Question: Describe this figure in one sentence.
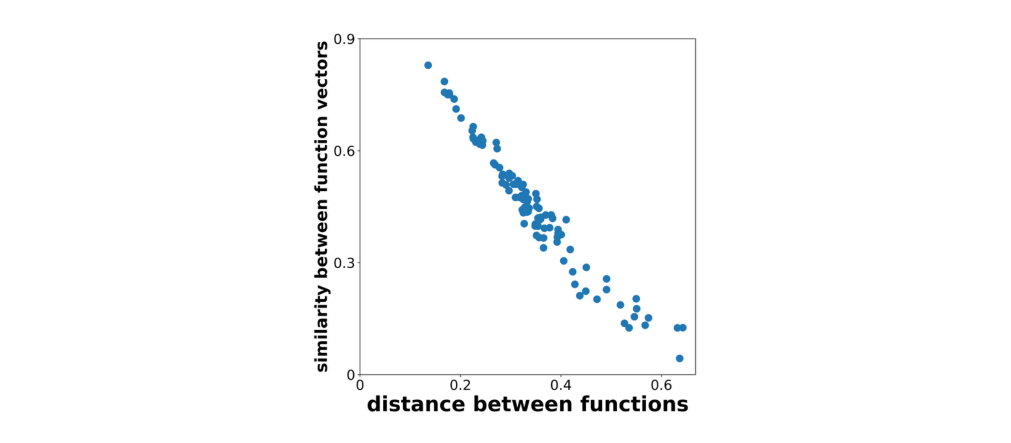
Answer: HDFE is a distance preserving transformation. The L2-distance between functions is proportional to the negative similarity between their encodings.